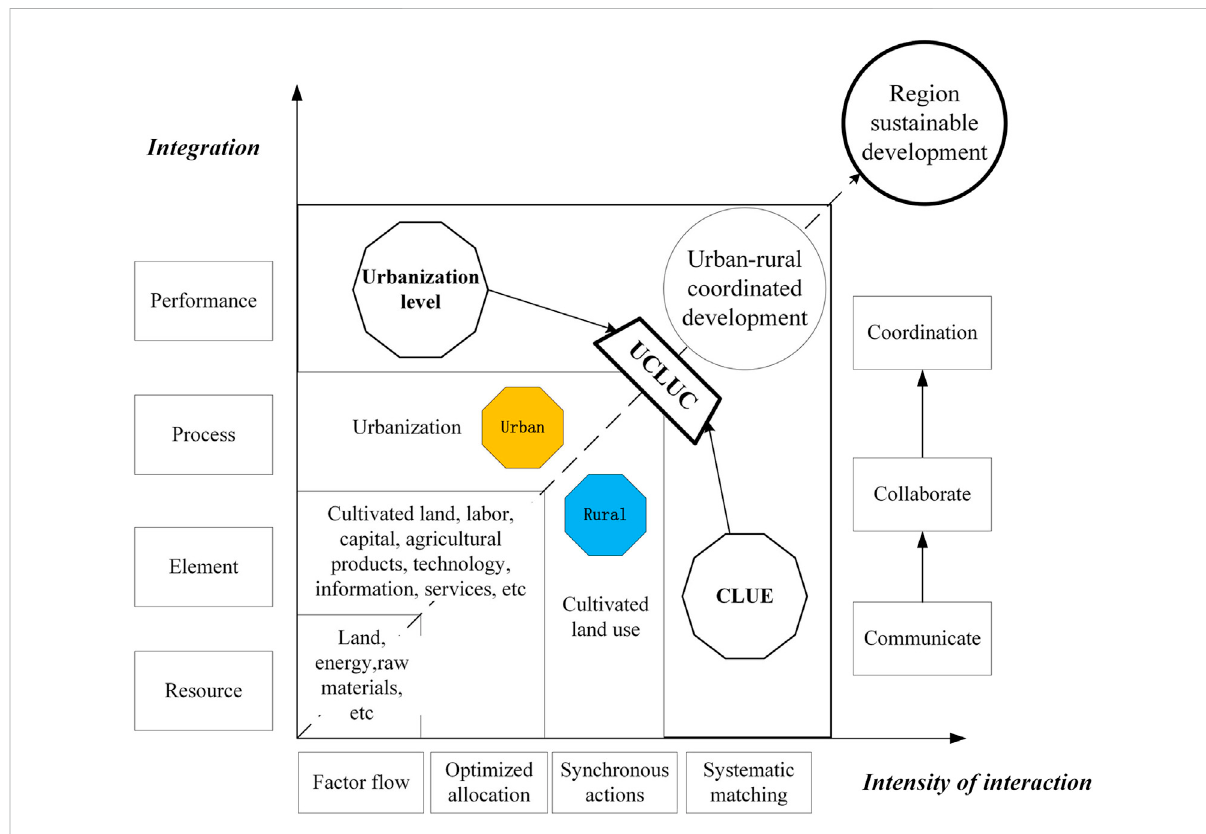
FIGURE 2 Analytical framework of